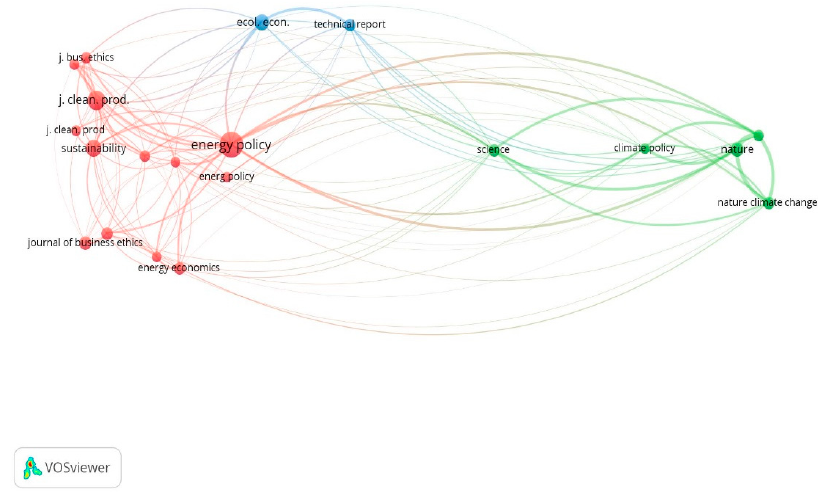
Figure 3. Co-citation of the top journals (line 215).